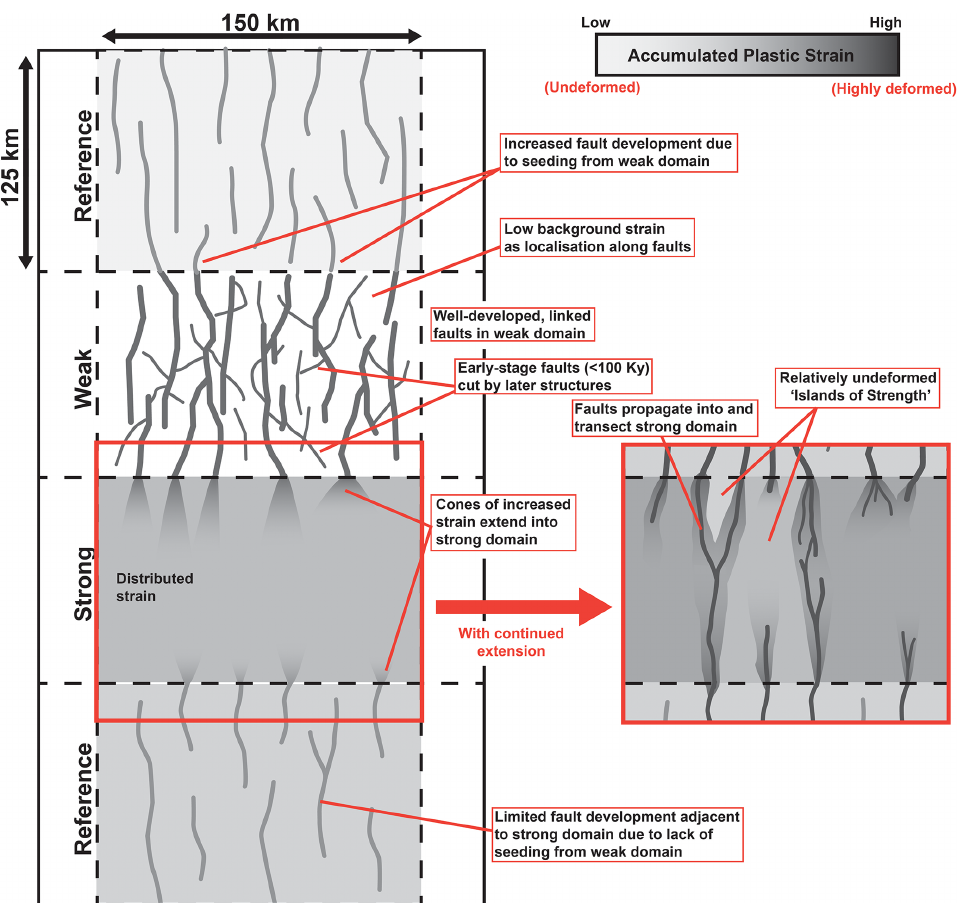
Figure 7. The characteristic structural styles associated with each domain and the key concepts demonstrated in our model. Cones of increased strain extend into the strong domain. As extension progresses, faults would eventually propagate into the strong domain, forming throughgoing structures that localise strain and relatively undeformed islands of